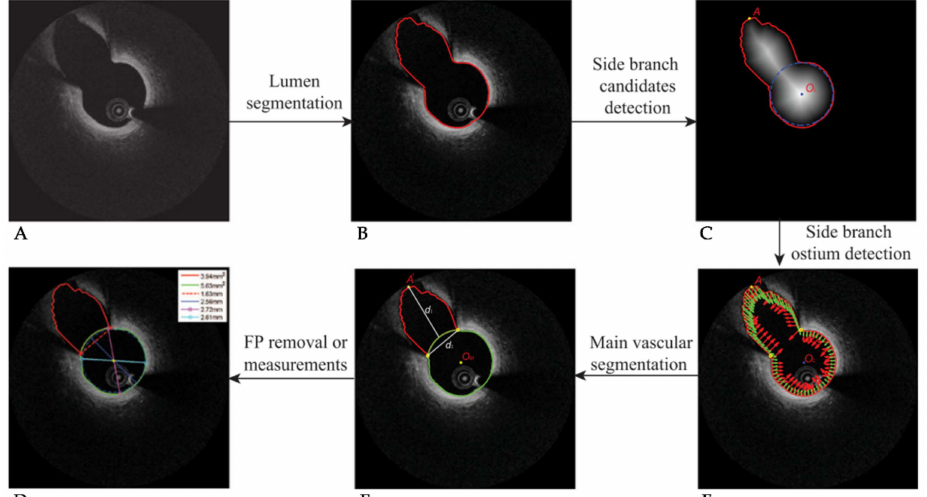
Figure 4. Visualization of the bifurcation identification method. ( A ) Original OCT image with bifurcation present. ( B ) Contour detection around lumen and branch. ( C ) Distance transform and the determined main vessel and side vessel centroids. ( D ) Final segmented image. ( E ) Detection of the side branch ostium location. ( F ) Normal vectors to the contour surface (red) and vectors pointing to the main vessel center (green). © [2017] IEEE. Reprinted, with permission, from [76].